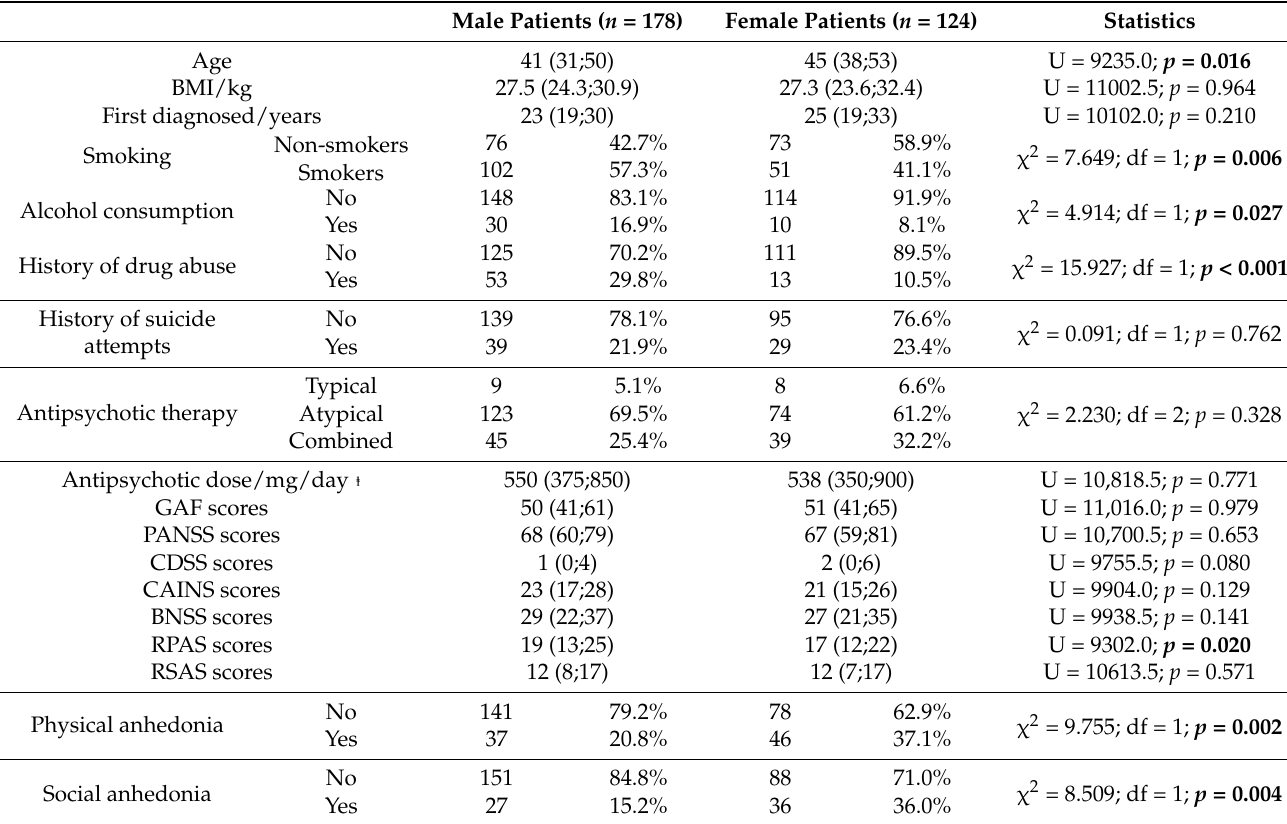
Table 1. Demographic and clinical data of patients with schizophrenia, depending on sex. The data are represented as total number and frequency or as median and interquartile range, while p values denoted in bold represent statistical significance. Table 2. The effect of demographic and clinical data on global functioning, severity of schizophrenia, depression, negative symptoms, and physical and social anhedonia in patients with schizophrenia, evaluated with a general linear model. p values in bold represent statistical significance.